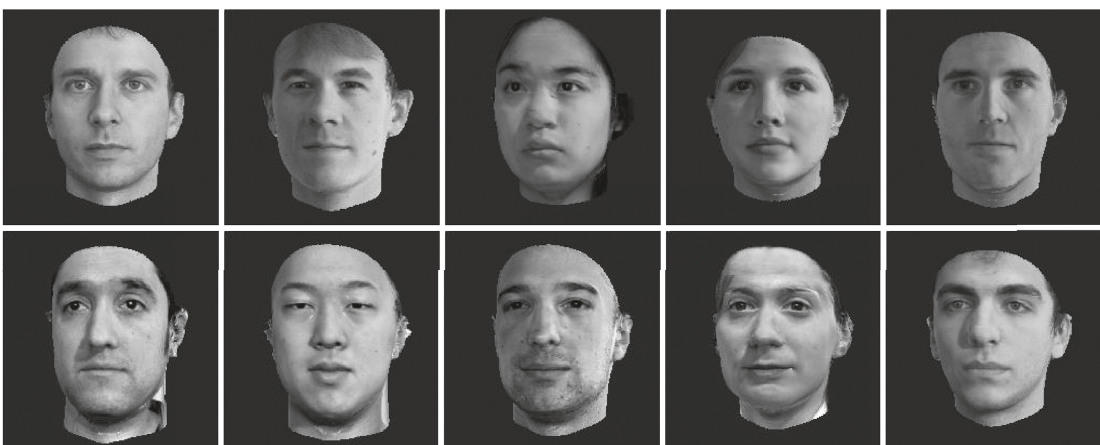
Figure 2: Sample images from MIT-CBCL